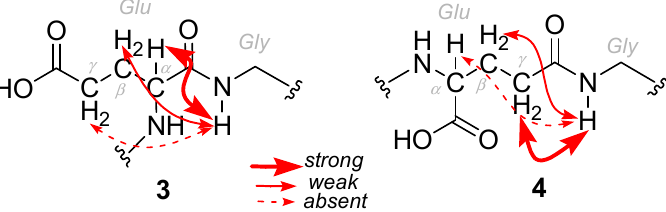
Figure 2. Relevant nuclear overhauser effect spectroscopy (NOESY) correlations for TSPO-ligand α -/ γ -MTX conjugates ( 3 and 4 , respectively).